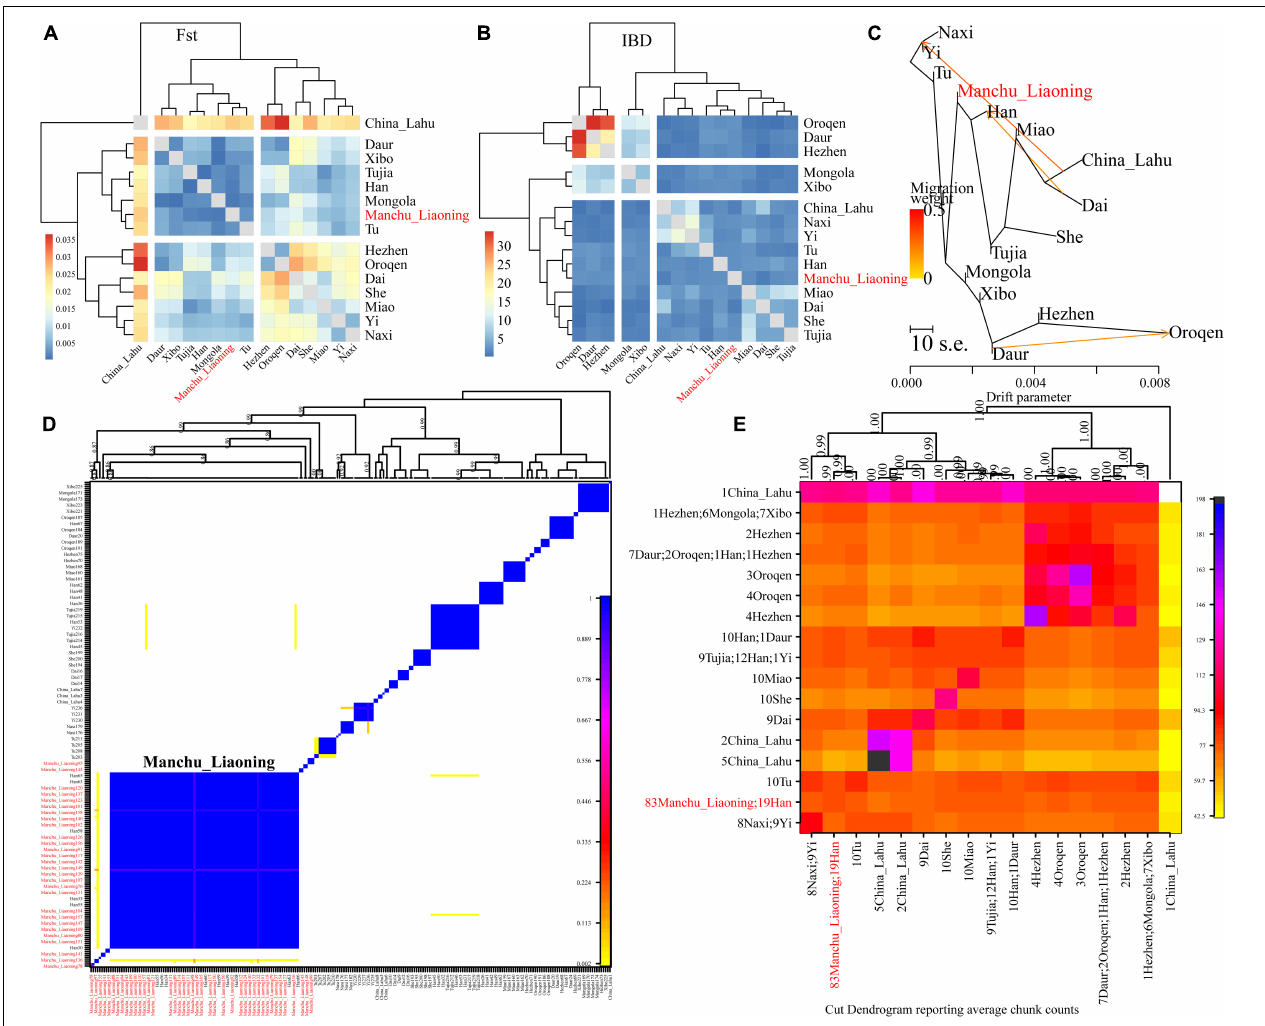
FIGURE 8 | The deep population history of Manchus inferred from both sharing alleles and haplotypes. (A,B) Heatmap shows the pairwise F ST genetic distance and identity by decedent (IBD). (C) The TreeMix-based phylogenetic tree shows the genetic relationship between Manchu people and other modern East Asians. (D,E) Clustering patterns based on the co-ancestry